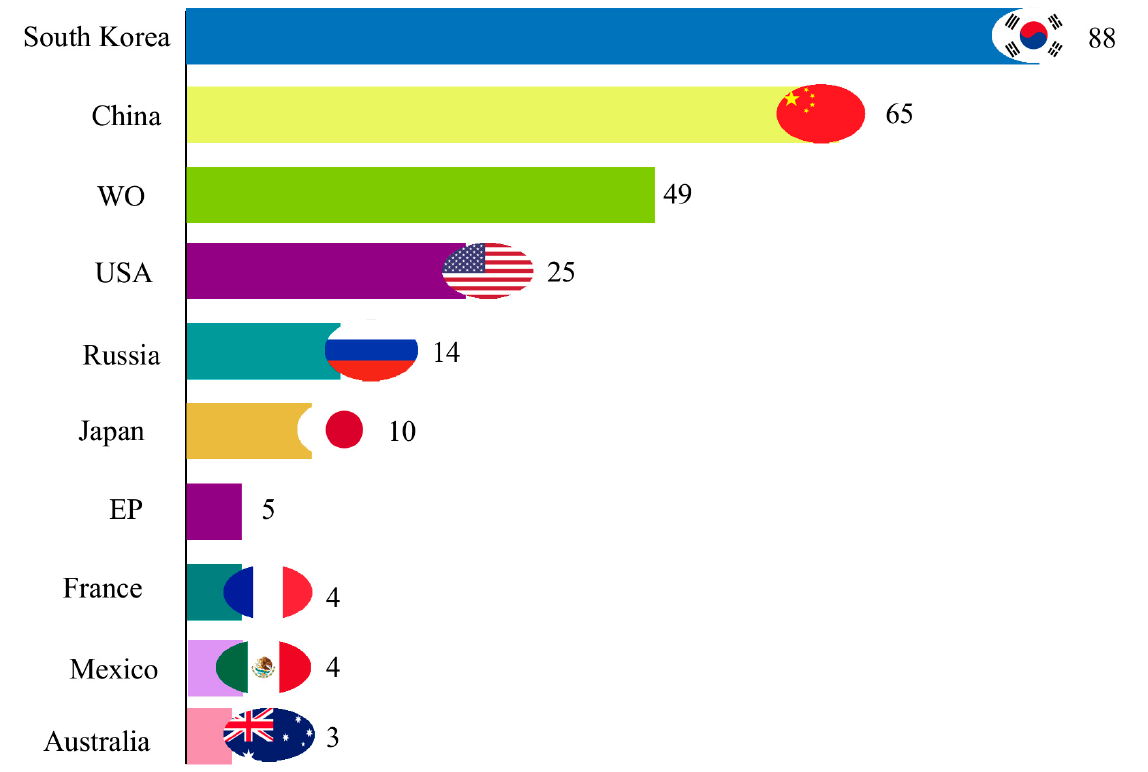
Figure 8. Distribution of patent filings by country. Created with flourish.studio [43]. EP: European Patent Office; WO: World Intellectual Property Organization.